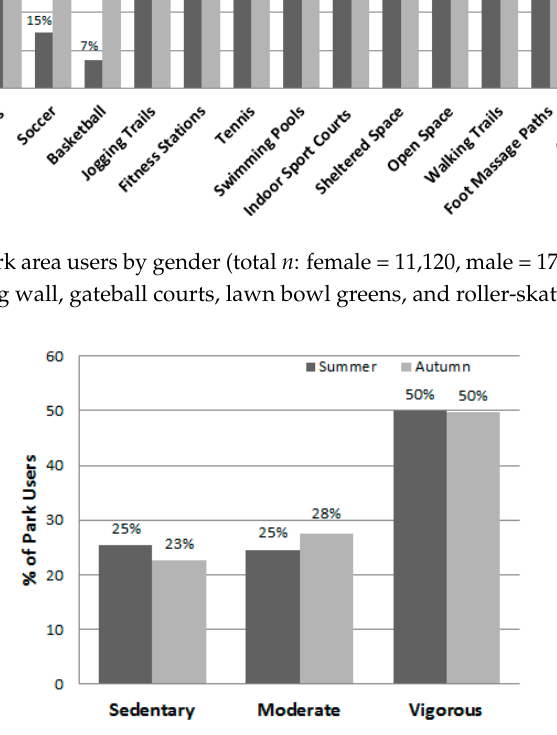
Figure 10. Percent of park users by physical activity levels and season ( n = 28,585). Table 7. Number of observed area visitors, PA intensity, and PA intensity by person and by gender.